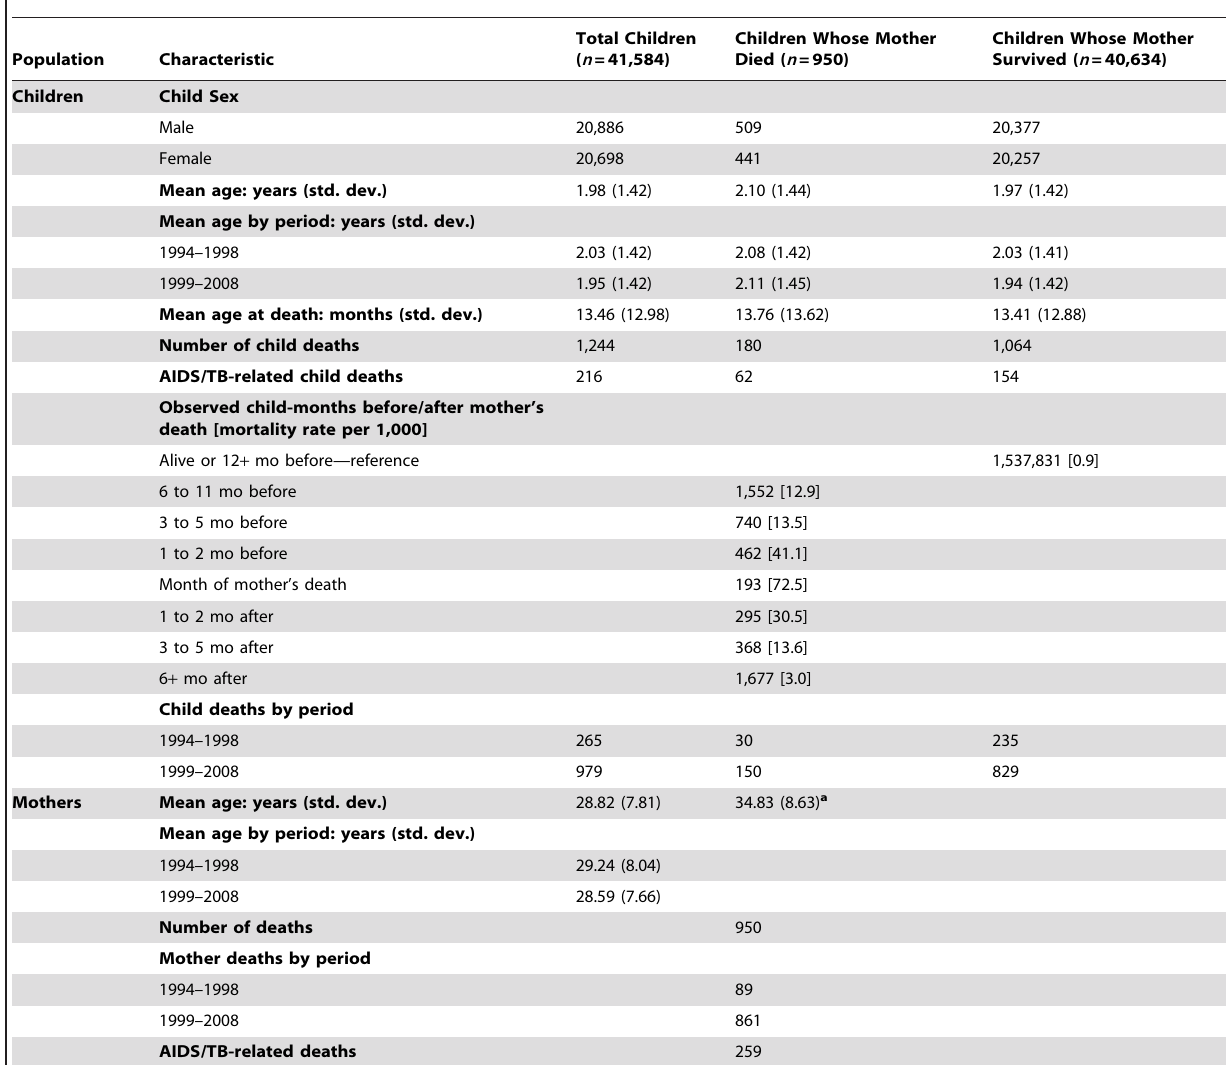
Table 1. Characteristics of children and their mothers for the periods 1994–1998 and 1999–2008, Agincourt sub-district, South